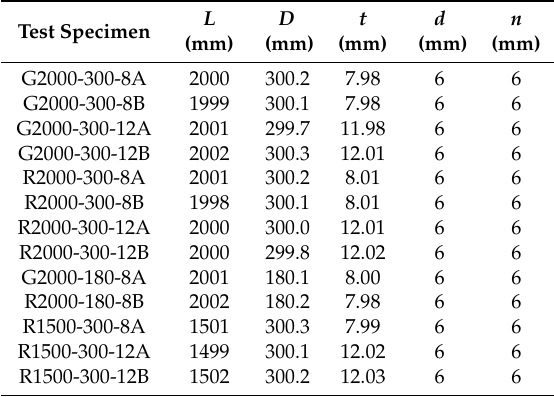
Table 2. Geometric size of test specimens.